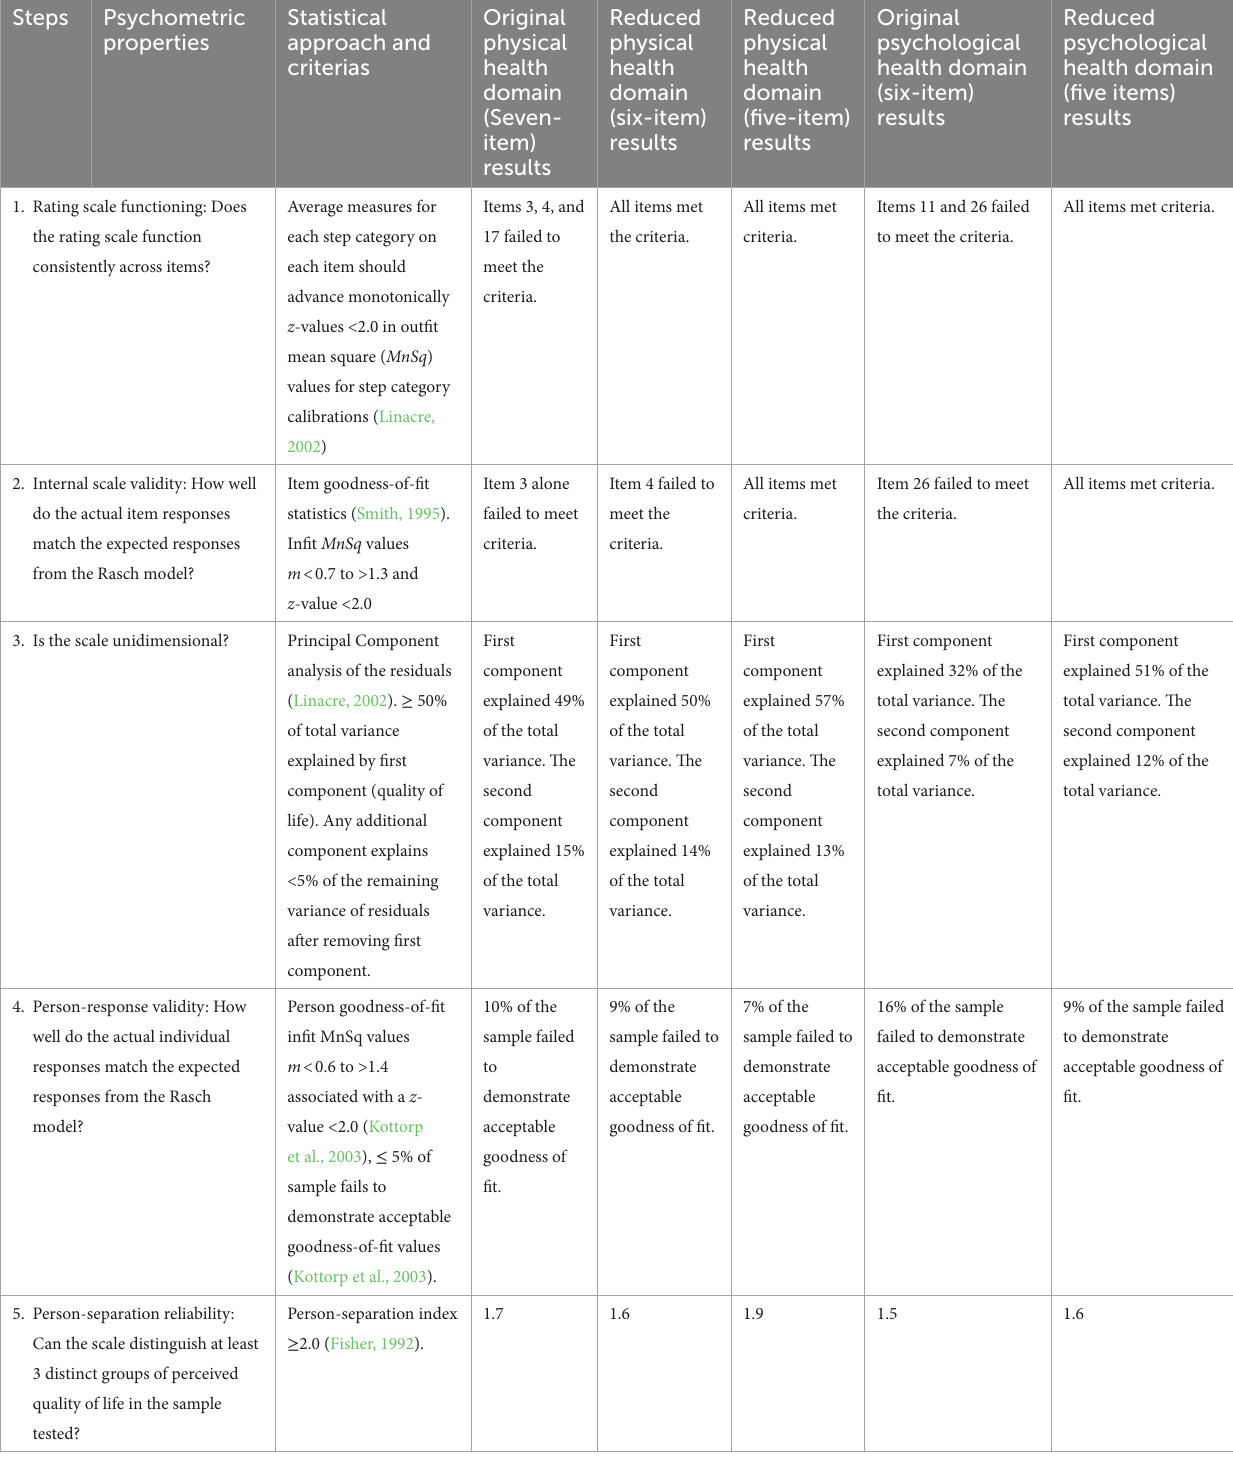
TABLE 4 Psychometric properties of the physical and psychological domains of the WHOQOL-BREF scale. Steps Psychometric